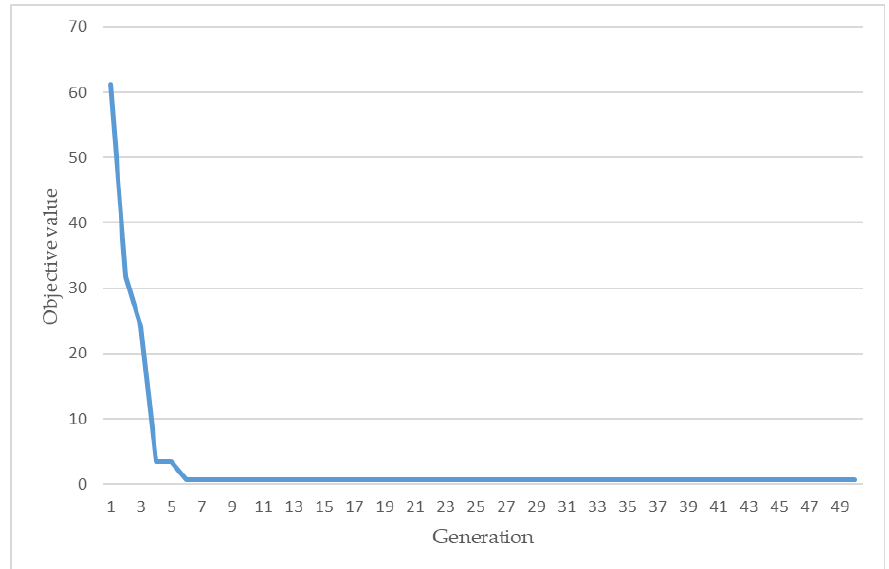
Figure 8. Obtained evolutionary trajectory by the parallel computing accelerated GA in this experiment.